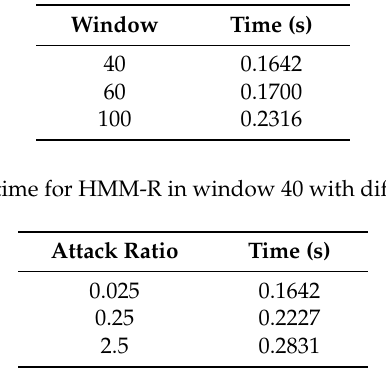
Table 7. Detection time of HMM-R in attack ratio of 0.025 with different windows.